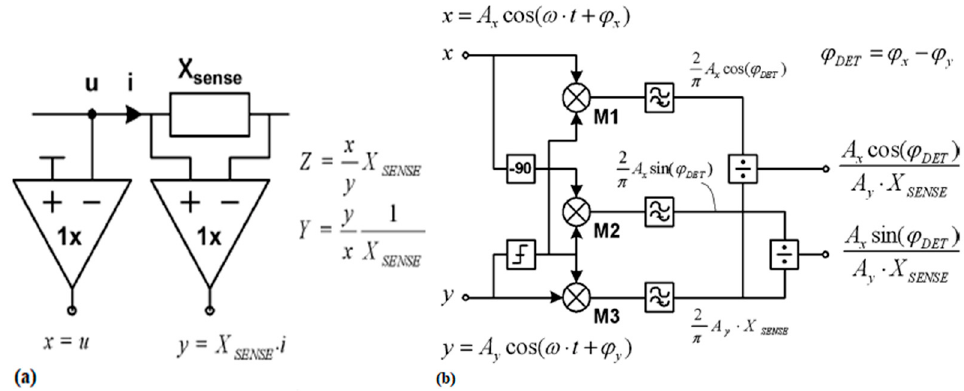
Figure 7. ( a ) Sensing circuit used for measuring RF voltage and current information [44]; ( b ) Generic quadrature detector used for providing the real and imaginary parts of the detected impedance [44].